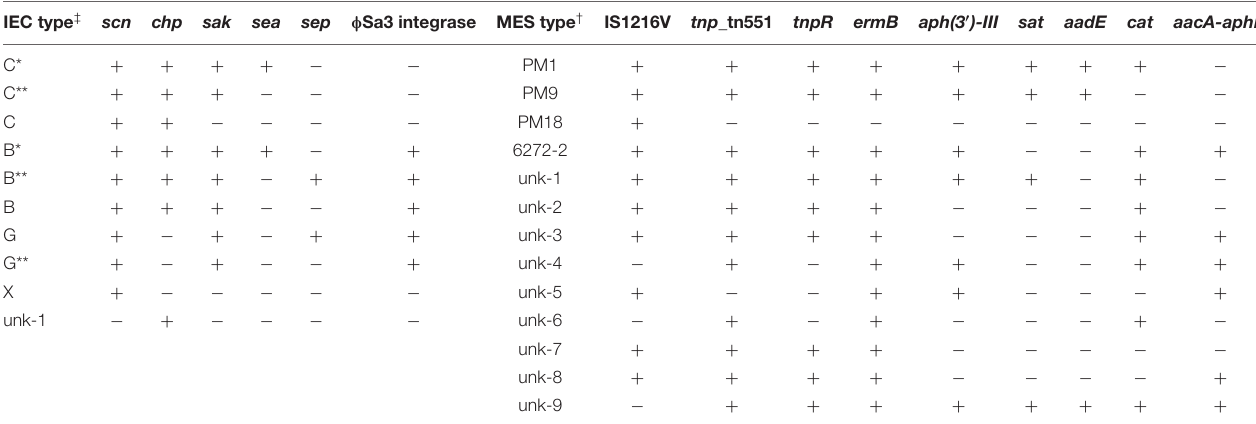
TABLE 2 | Immune Evasion Complex (IEC) and Mobile Elements Structure (MES) types, along with their associated genes, detected in the ST59